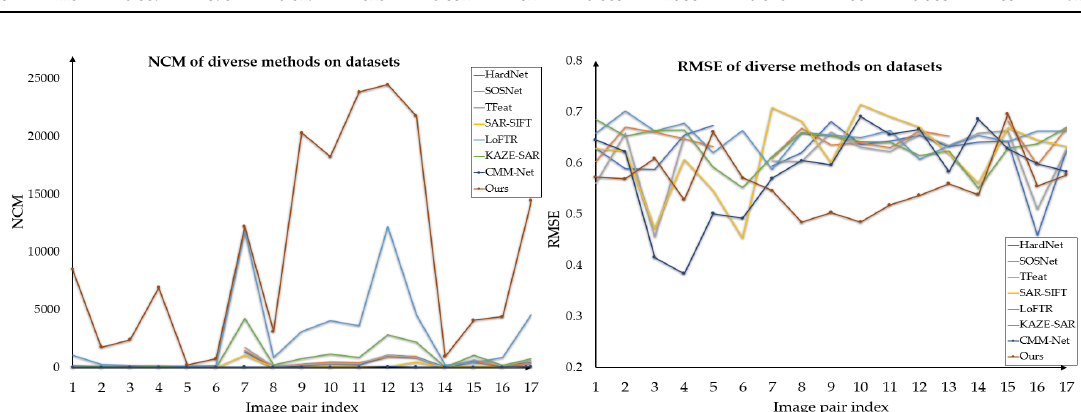
Figure 9. NCM and RMSE of diverse methods on the datasets.